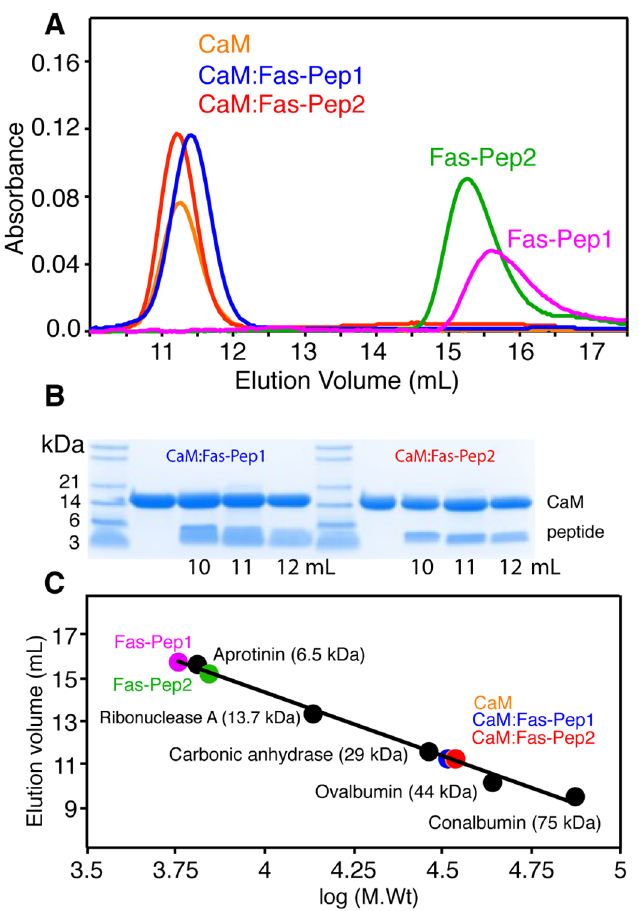
Fig 3. Gel filtration data of Ca 2+ /CaM complexes with recombinant FasDD peptides. ( A ) Gel filtration chromatograms of Ca 2+ /CaM complexes with FasDD peptides using a HiLoad Superdex 75 (10/300 GL) column. ( B ) Complex formation has been confirmed by SDS-PAGE. Two bands of CaM and peptides are clearly observed. Elution of the peptides with CaM indicates direct binding. ( C ) Gel filtration calibration curve with indicated mobility of Ca 2+ /CaM, FasDD peptides and their complexes. The approximate molecular weights of complexes suggest a 1:1